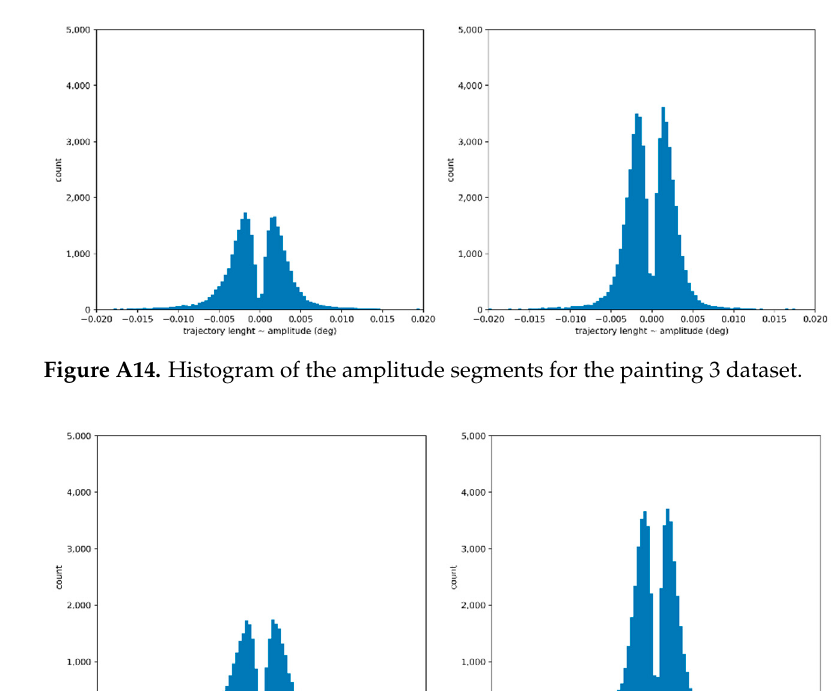
Figure A13. Histogram of the amplitude segments for the painting 2 dataset.